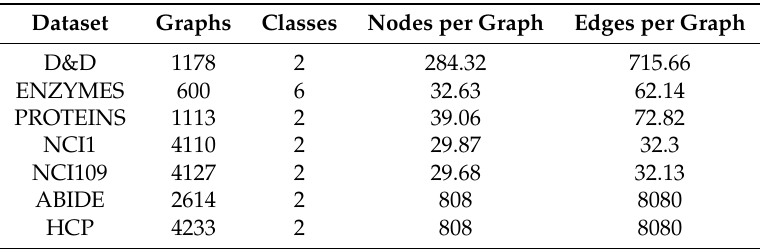
Table 2. Statistics information of